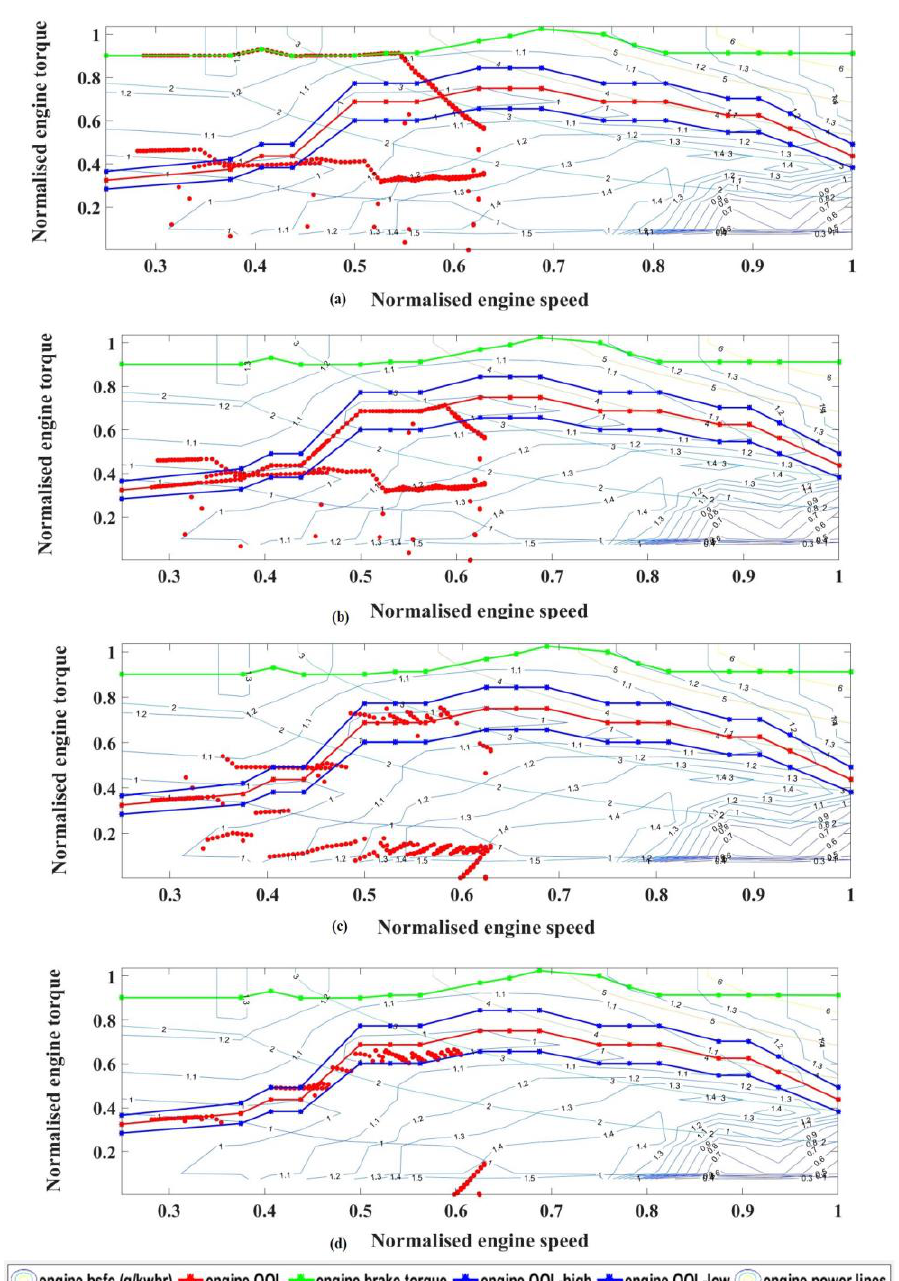
Figure 9. Veh1 engine operating points for different controllers tested for the IDC test cycle: ( a ) BEMS, ( b ) MEMS, ( c ) ECMS and ( d ) ECMS_LL.